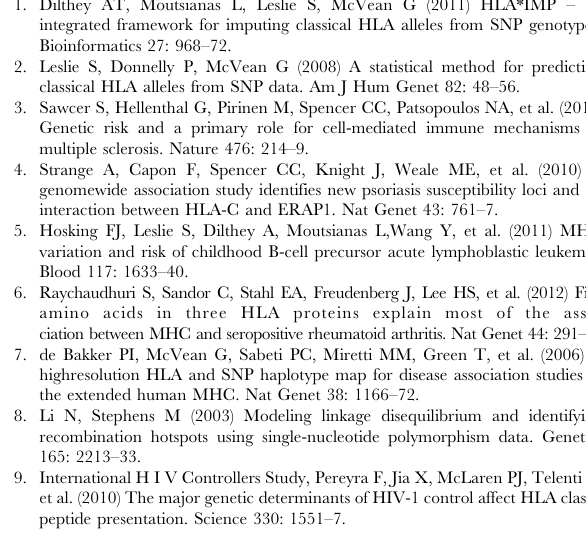
represent the haplotypes carrying the 02:01 allele in the reference panel. Red and green rows represent haplotypes carrying 02:01 in the validation panel, with green indicating successful imputation and red indicating misimputation. We only show SNPs selected by HLA*IMP:01 in the process of SNP selection, and the inferred haplotypes are taken from the phased reference panel for HLA*IMP:01. The inferred haplotype structure in the second experiment in more complex than in the first experiment. Comparing correctly and incorrectly imputed haplotypes in the second experiment, it is clear that there are features (highlighted) which appear virtually exclusively in incorrectly imputed haplo- types (although they are present in the reference panel). Note that A*02:01 is imputed virtually perfectly by HLA*IMP:02 in this experiment, consistent with our hypothesis that HLA*IMP:02 is more tolerant of heterogeneous haplotype structures. Table S1 HapMap-based BC58 validation accuracy. Accu- racies (PPV) for the HapMap-based BC58 validation, as described in Leslie et al. [2] and Dilthey et al. [1]. No call threshold is employed. The column ‘‘HLA*IMP:02’’ refers to the full model with error parameters != 0 and localization (other parameters set to accommo- date the much reduced sample size). In column I, the error probabilities for sampling from the graph ( m S ) and for building the graph m B are set to 0 (all other parameters equal to the column ‘‘HLA*IMP:02’’). In column II, the error probability for building the graph is set to 0, and in column III, the error probability for sampling from the graph is set to 0.